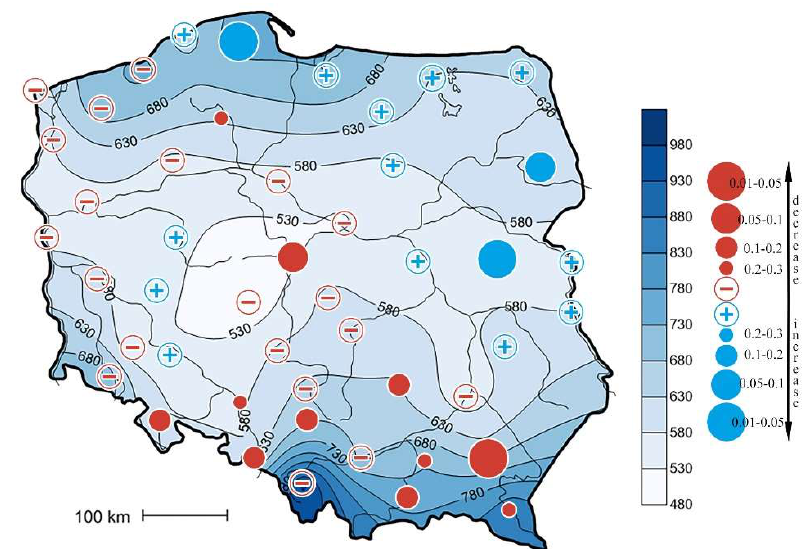
Figure 2. Spatial distribution of annual precipitation totals [mm] in 2001–2018 and the level of significance of changes in the annual precipitation total in 2001–2018 based on the Mann–Kendall test. In spring, precipitation totals generally increased from northwest to southeast. Northwestern Poland had rainfall below 130 mm; on the Escarpment of the Carpathian Foothills, it reached 150 mm and in the higher parts of the Carpathians 190 and 210 mm. Only four stations located in eastern Poland showed a statistically significant increase in spring rainfall: Białystok at the level of 0.01–0.05, Włodawa at the level of 0.05–0.1 and Kętrzyn and Terespol at 0.1–0.2. Another three stations located in this part of Poland, i.e., Lublin, Sandomierz, and Suwałki, showed a statistically non-significant increase in spring rainfall. Most of the other stations showed a drop in spring precipitation, including Leszno, and Wieluń at 0.2–0.3 (Figure 3).